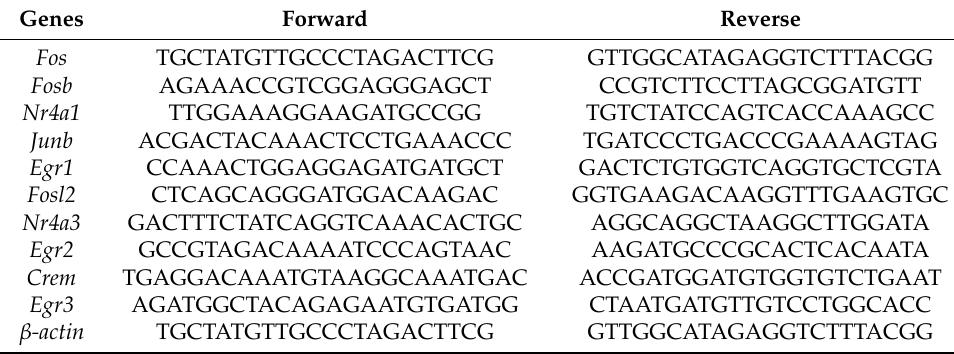
Table 1. Primer sequence of genes selected for qPCR